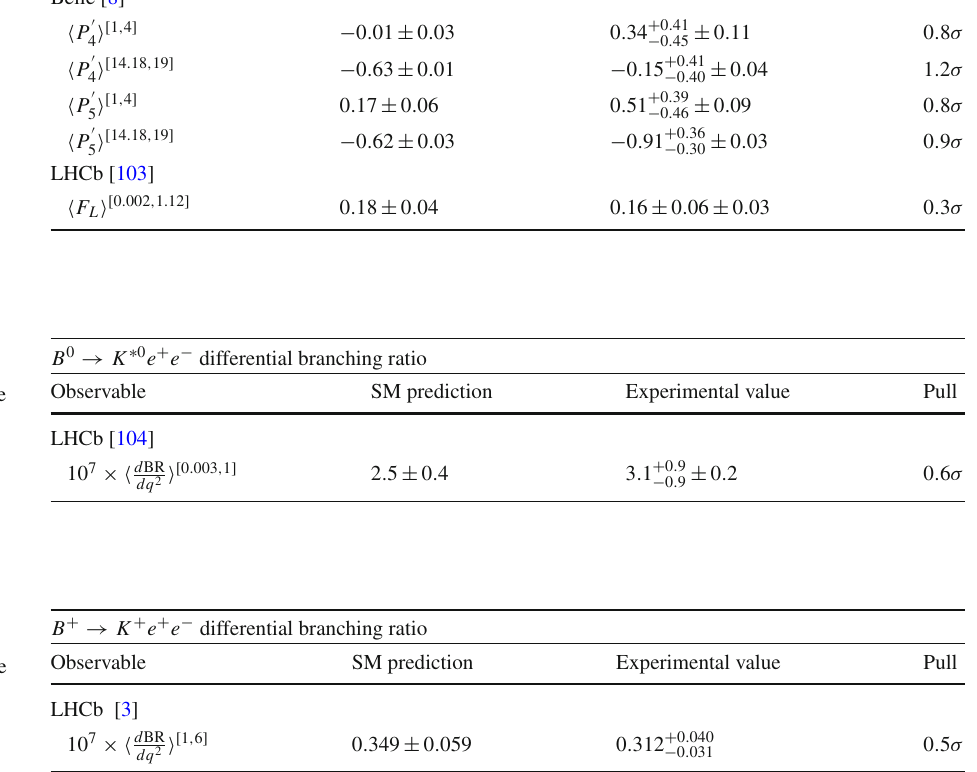
of B 0 → K ∗ 0 e + e − included in the global fit